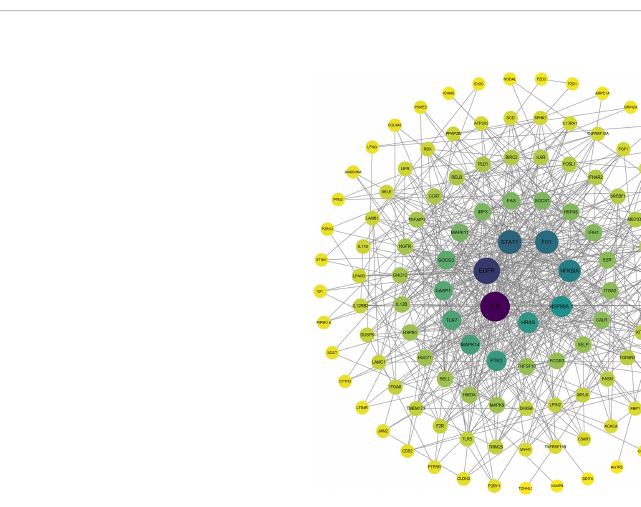
FIGURE 10 Protein interaction network analysis of immune-related upregulated genes on day 7 after challenge.